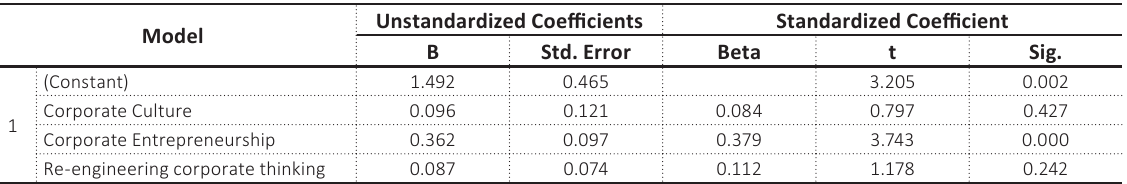
Table 9. Regressing intrapreneurship sub- variables on the sales volume